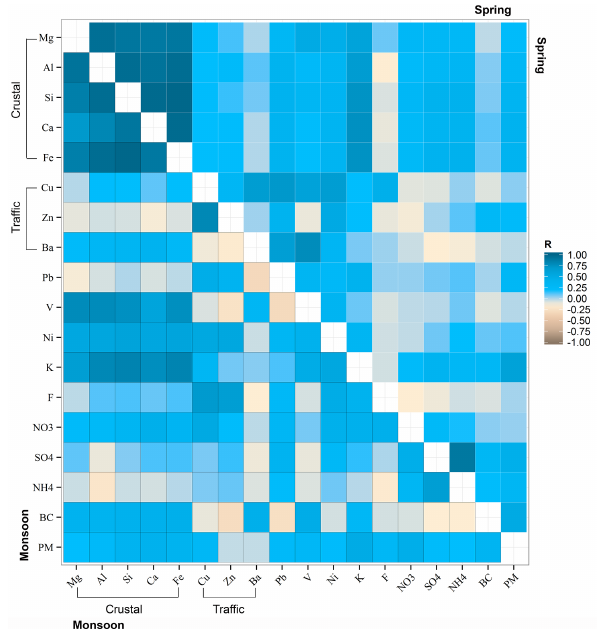
Figure 7. The matrix of correlation coefficients between elements, ions, BC, and PM 2 . 5 concentrations observed at six sites in the Kathmandu Valley in the spring season (above diagonal of white boxes) and monsoon season (below diagonal of white